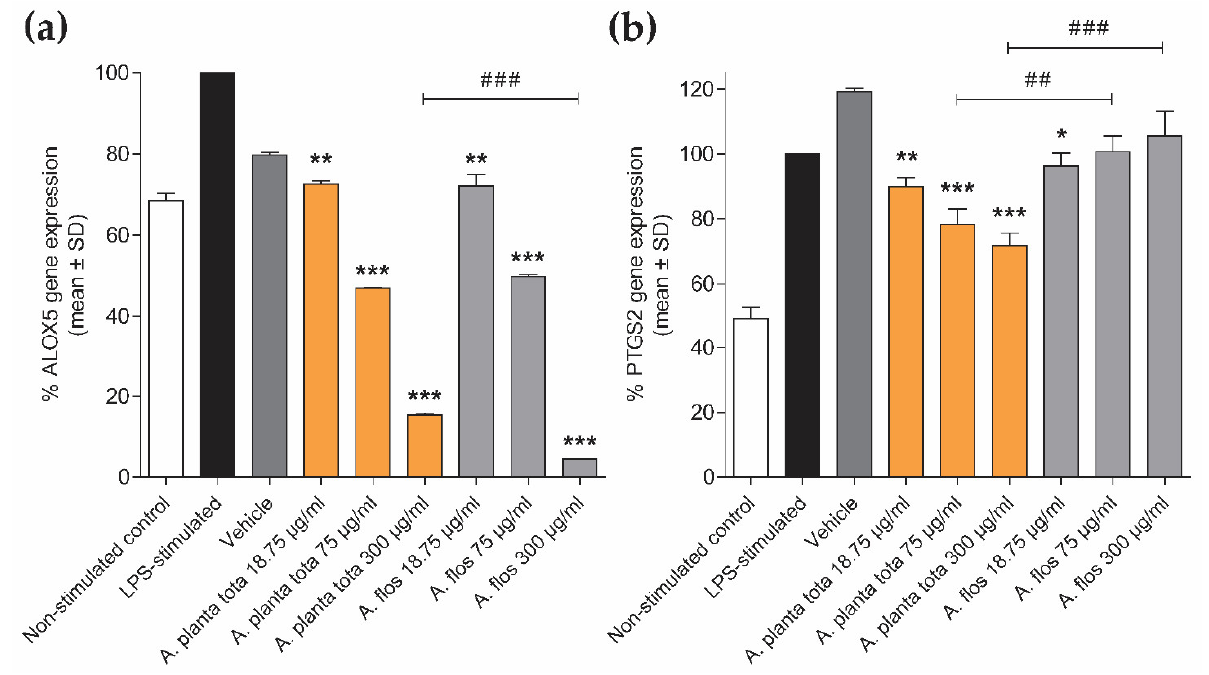
Figure 3. Inhibition of ALOX5 ( a ) and PTGS2 ( b ) gene expression by Arnicae planta tota and Arnicae flos in LPS-stimulated THP-1 cells. Human monocytic THP-1 cells were differentiated into macrophages, pre-treated for 4 h with increasing concentrations of Arnicae planta tota and Arnicae flos, and stimulated for 24 h with LPS before gene expression analysis using RT-qPCR. Data are expressed as the percentage of inhibition of ALOX5 and PTGS2 gene expression relative to the LPS-stimulated control. Data are given as mean ± SD of three biological replicates from one representative experiment out of two independent experiments. Differences in gene expression in Arnica-treated conditions vs. vehicle control were tested using a one-way ANOVA followed by Dunnett’s multiple comparison test (*, p < 0.05; **, p < 0.01; ***, p < 0.001). A further comparison of gene expression inhibition at the respective concentrations of Arnicae planta tota vs. Arnicae flos showed a significantly stronger inhibition of ALOX5 expression at 300 µg/mL Arnicae planta tota vs. Arnicae flos (# # #, p < 0.001), and a stronger inhibition of PTGS2 expression at 75 µg/mL Arnicae planta tota vs. Arnicae flos (# #, p < 0.01) and at 300 µg/mL Arnicae planta tota vs. Arnicae flos (# # #, p < 0.001). Abbreviations: ALOX5, arachidonate 5-lipoxygenase; A. planta tota, Arnicae planta tota; A. flos, Arnicae flos; LPS, lipopolysaccharide; PTGS2, prostaglandin-endoperoxide synthase 2. Cytotoxicity control is shown in Figure